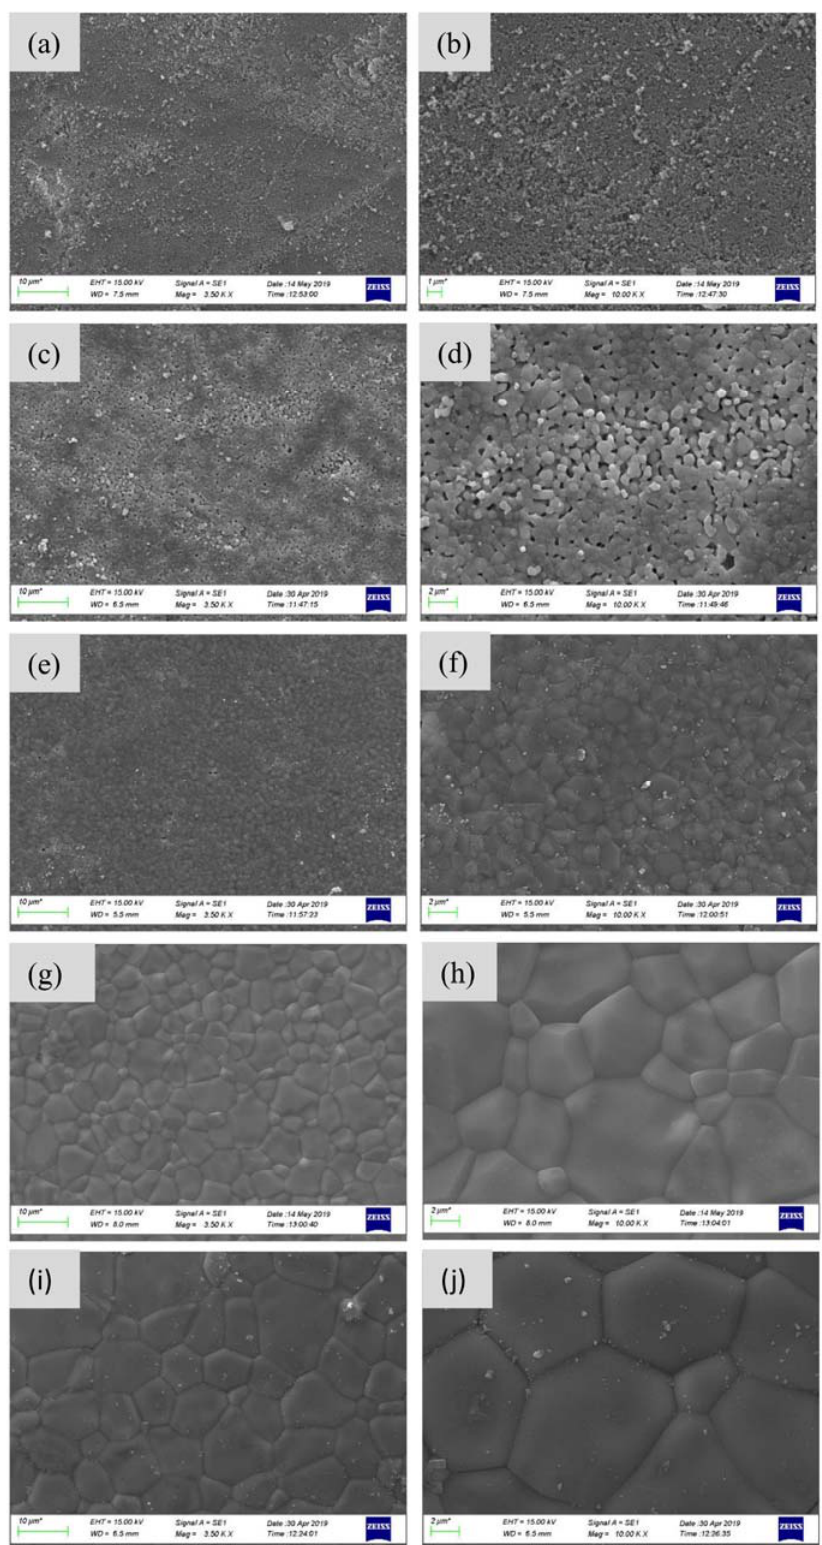
Figure 5. SEM micrographs of sCaP samples at different sintering temperatures; ( a , b ), 800 °C, ( c , d ) 1000 °C, ( e , f ) 1100 °C, ( g , h ) 1200 °C, and ( i , j ) 1300 °C.